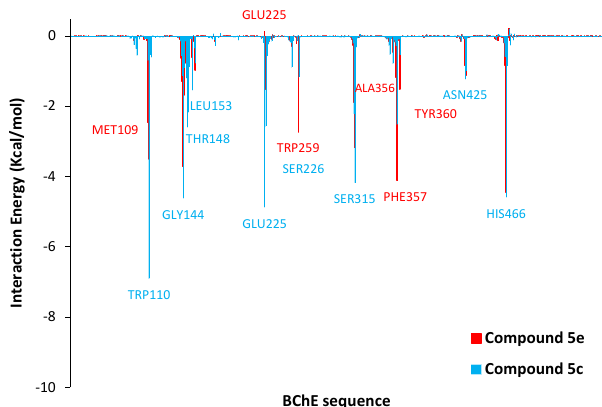
Figure 4. Histogram of interaction energies partitioned with respect to BChE amino acid sequence when complexed with compounds 5c (blue) and 5e (red) overlaid for comparison. The X-axis denotes the residue number of BChE, and the Y-axis denotes the interaction energy between the compound and a specific residue. Negative and positive values are favorable or unfavorable for binding, respectively.